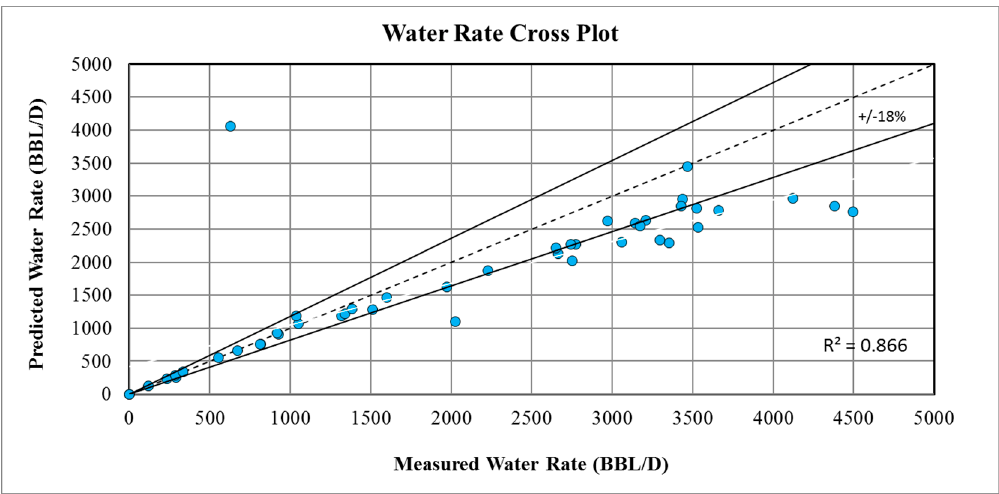
Figure 12. Predicted vs measured water rate using the Darcy correlation.